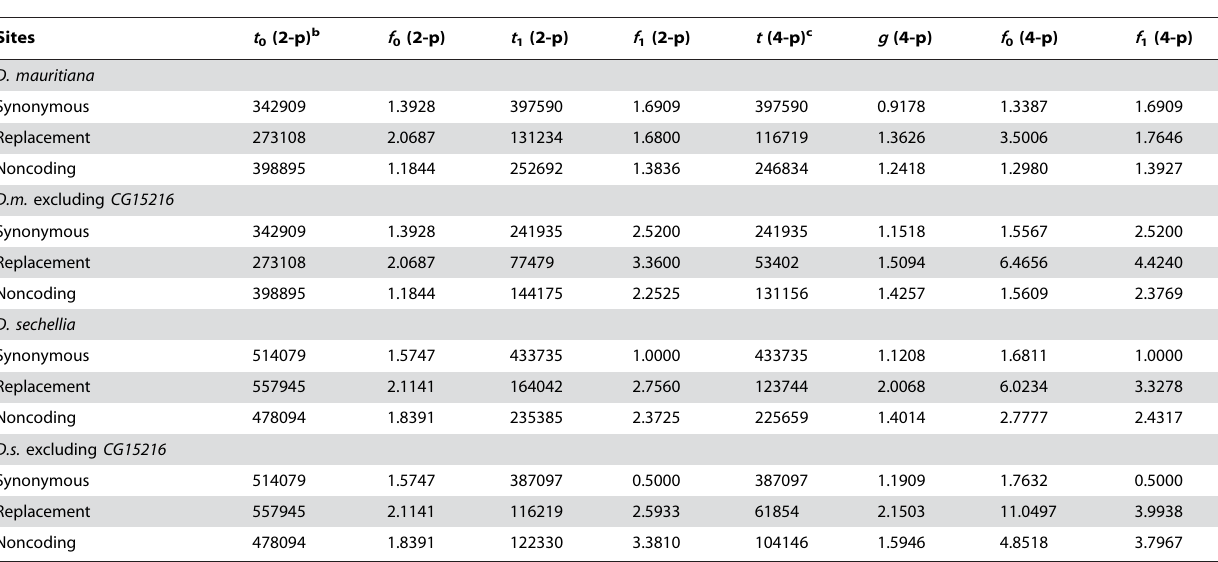
Table 7. Parameter estimates using synonymous, replacement or noncoding sites a